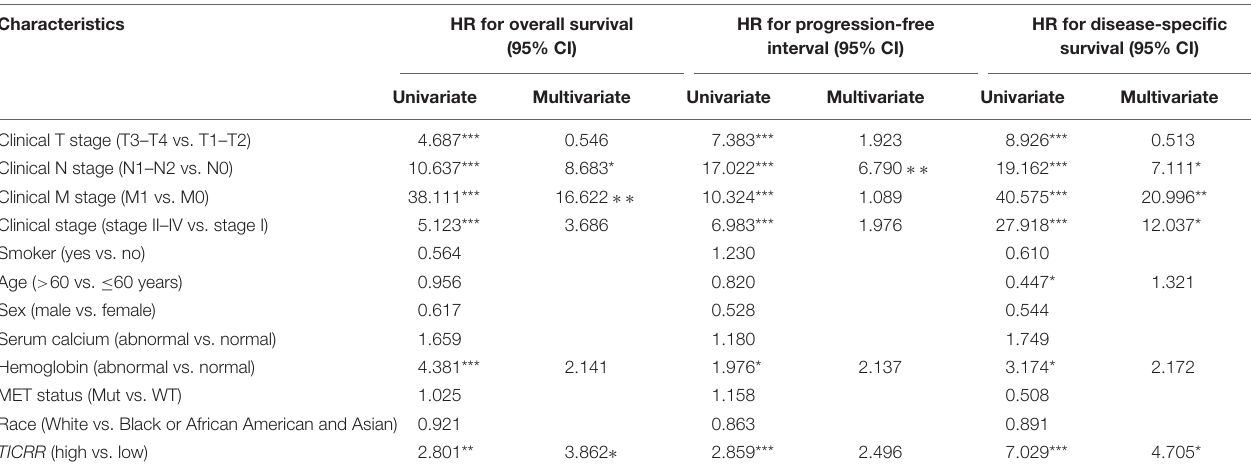
TABLE 3 | Cox regression analysis for clinical outcomes in PRCC